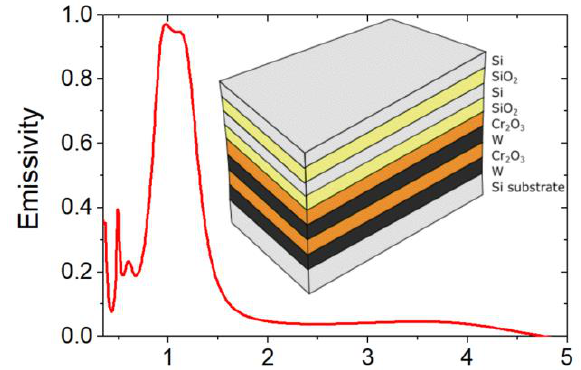
Fig. 1 : Absorption spectrum of a multilayer based on Si, W, SiO 2 , and Cr 2 O 3 .